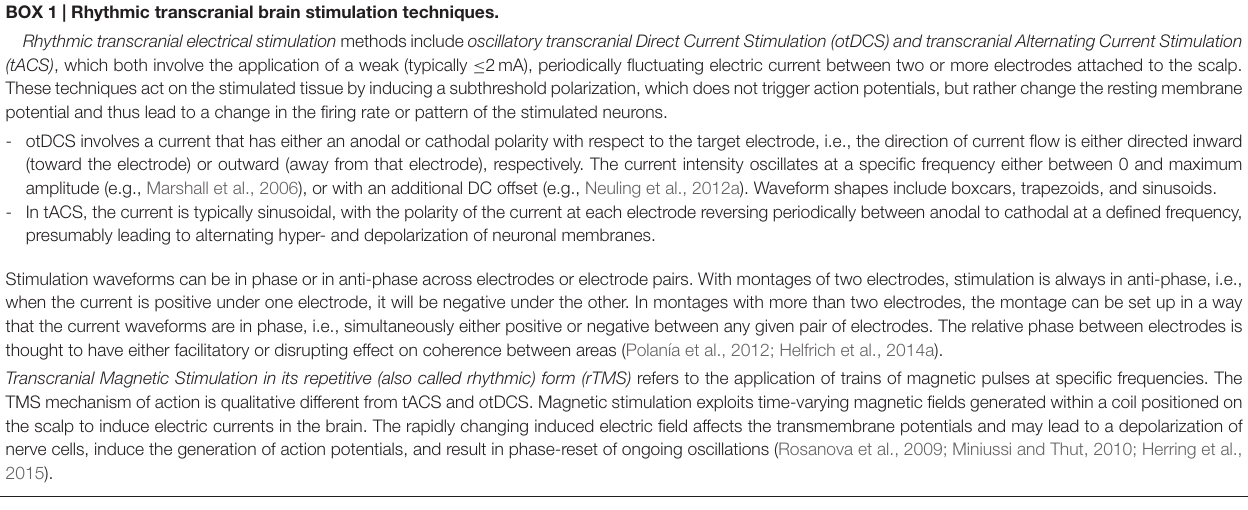
( Table 2 , total of 33 experiments) investigating EEG/MEG- aftereffects. We asked three questions: How consistently are aftereffects on brain oscillations reported across studies? Do these aftereffects show replicable patterns across experiments that suggest direct interactions with brain oscillations as their origin (including effects on intrinsic activity at stimulation frequency and/or its (sub)harmonics, or through known cross-frequency interactions)? And to what extent do such aftereffects translate into predictable behavioral